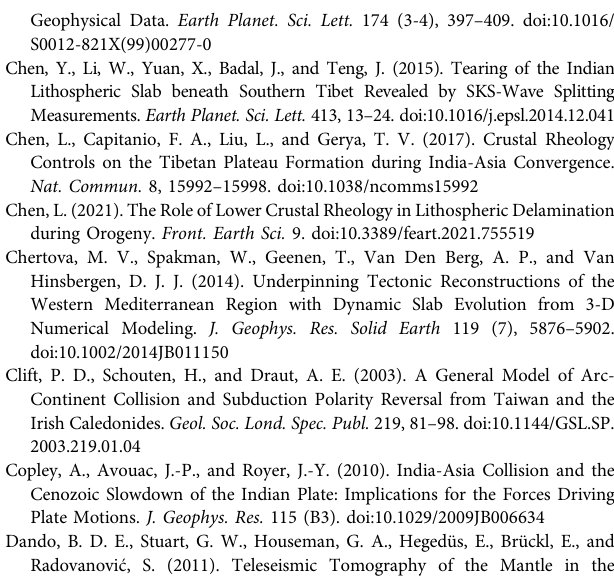
Supplementary Figure S1 | Viscosity fi elds of models in VDS with variable subducting angle (30 ˚ , 45 ˚ , 60 ˚ ) and continental convergence velocity (3 cm/year, 5 cm/year, 7 cm/year) correspond to Figure 8. Supplementary Figure S2 | Viscosity fi elds of models in VDS with variable retrocontinental lower crustal strength (weak, medium, strong) and dip angle (30 ˚ , 45 ˚ , 60 ˚ ) correspond to Figure